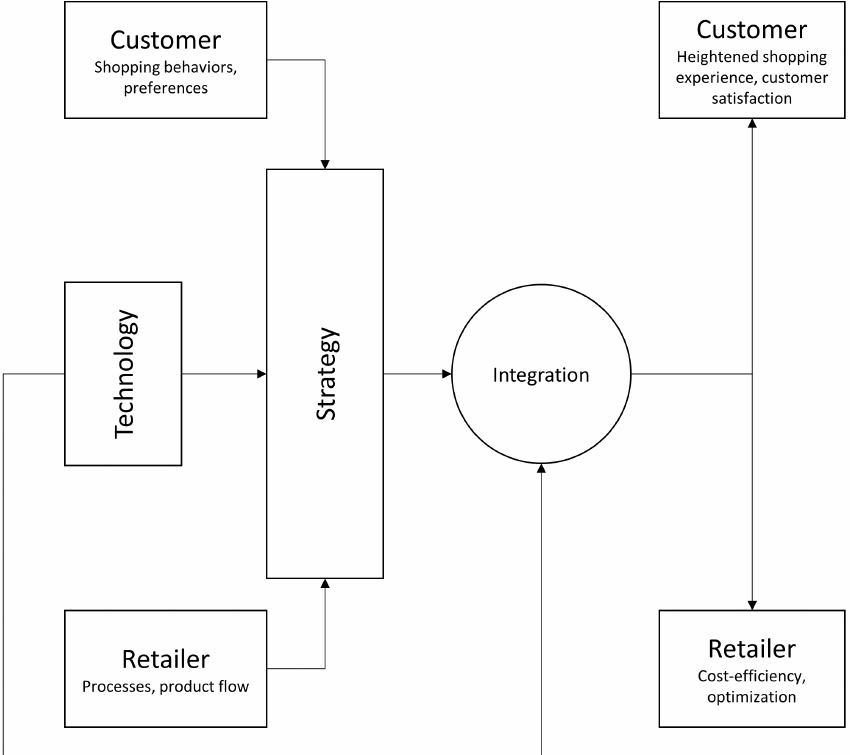
Figure 1. Framework for future research on omnichannel